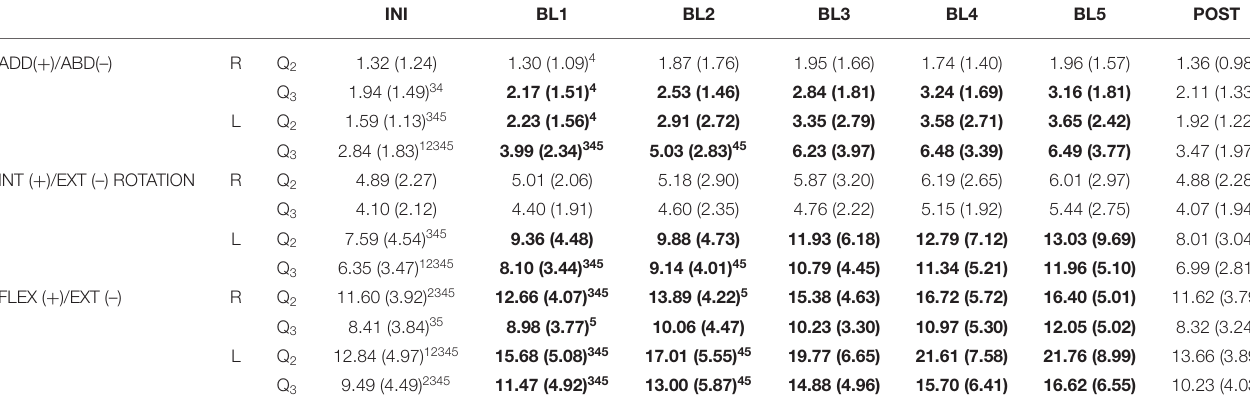
TABLE 3 | Average (1 SD) bilateral shoulder joint moment components in N.m during Q 2 and Q 3 . INI BL1 BL2 BL3 BL4 BL5 POST